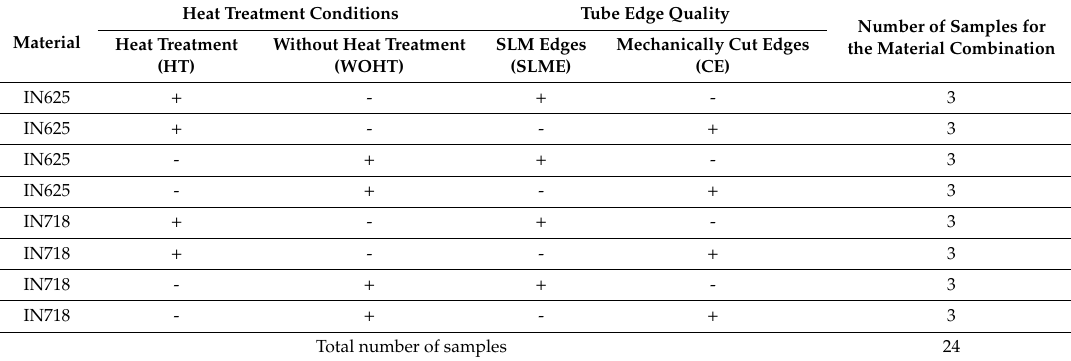
Table 3. Material combinations for the welding. SLM: selective laser